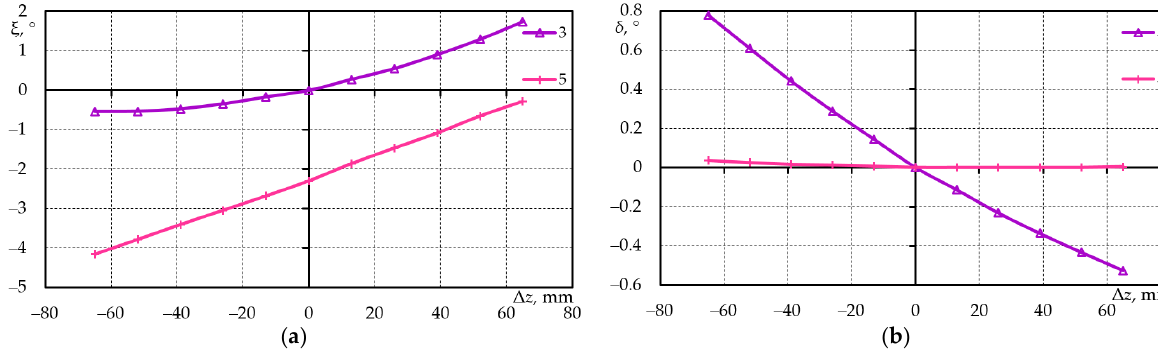
Figure 25. Dependence of wheel camber ( a ) and slip angle ( b ) on vertical wheel travel (marking according to Table 2).